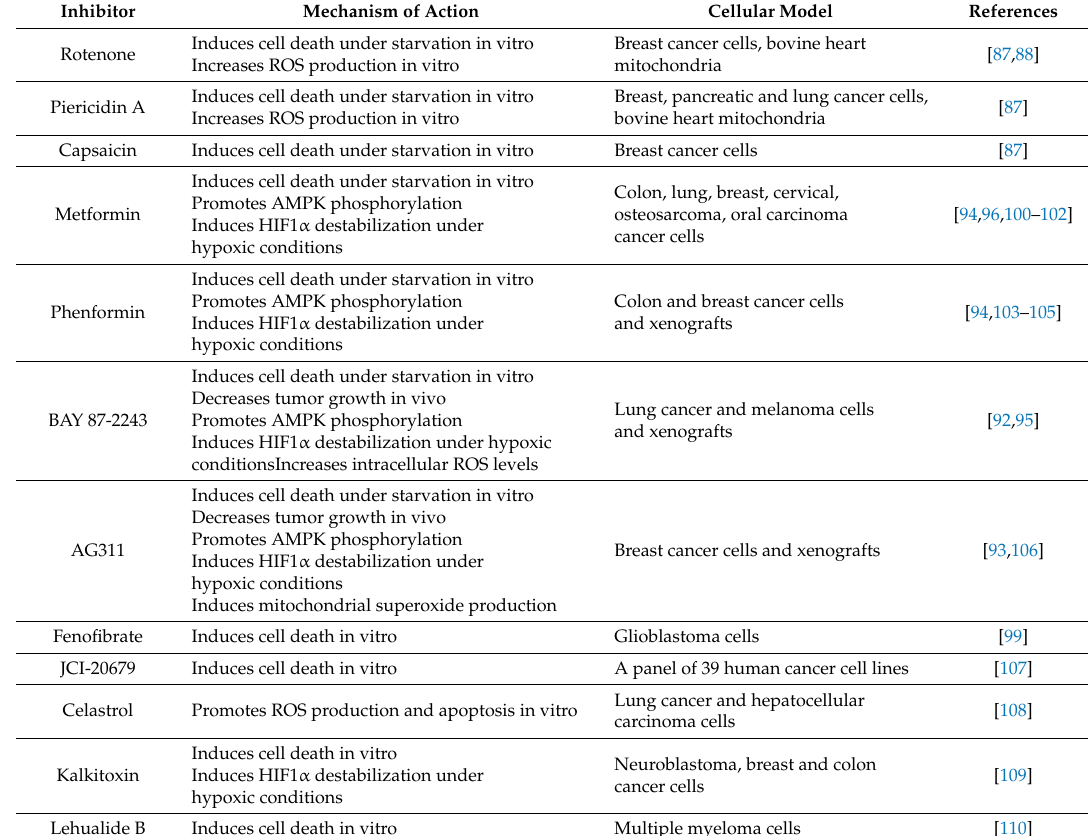
Table 1. Mitochondrial CI inhibitors with anti-cancer